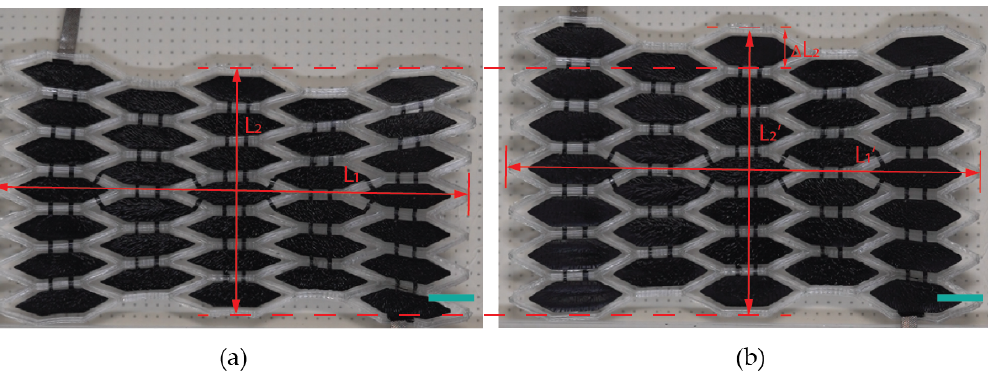
Figure 9. The actuator configurations: ( a ) the released state before activation and ( b ) the most deformed state at 7.5 kV. The scale bar is 8 mm.